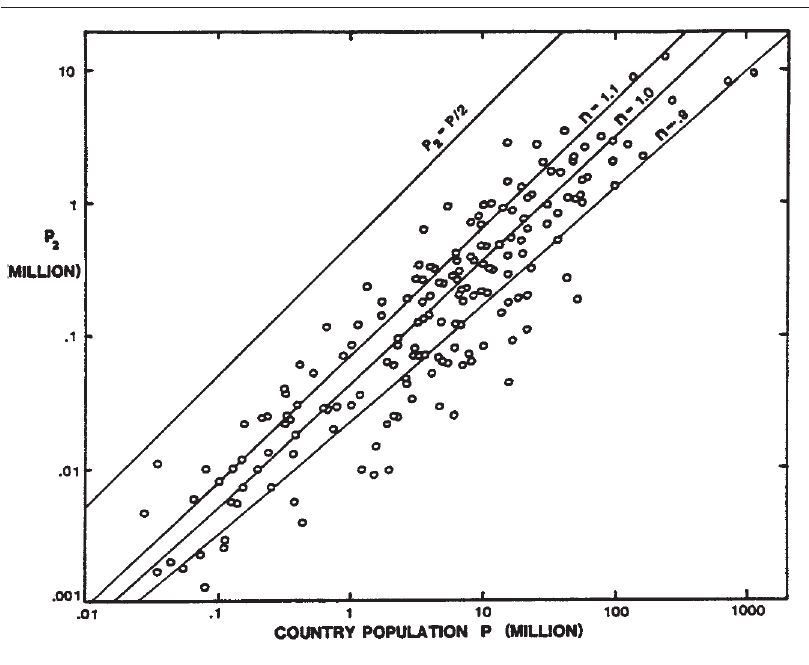
Figure 2 – Population of the second-largest city as a function of the total population of the country.